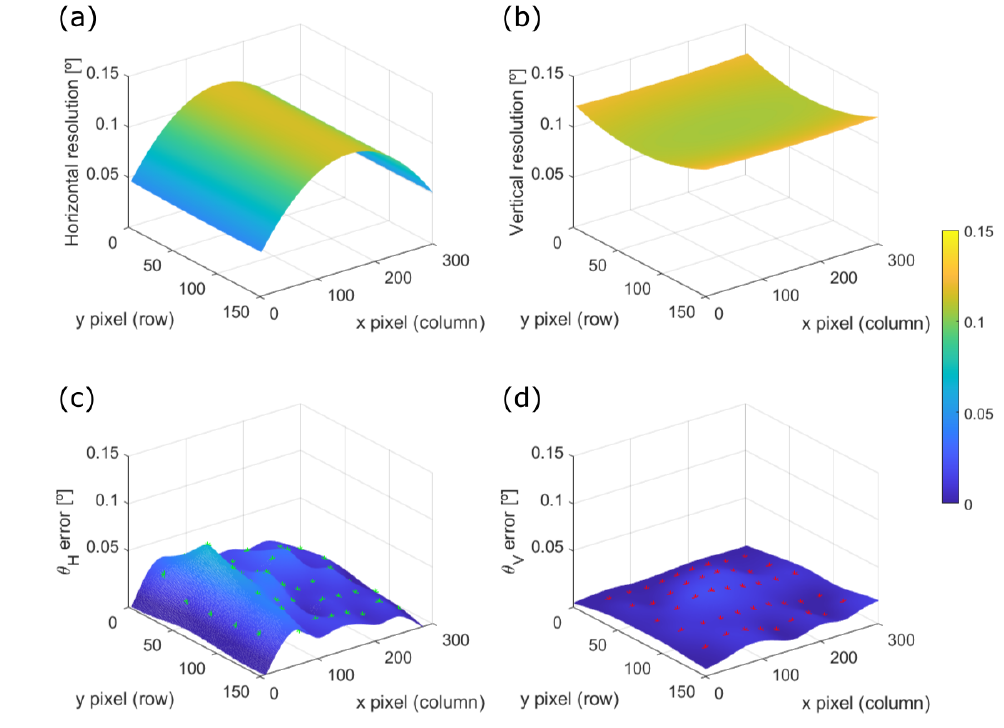
Figure 13. Results of the mapping function Map 3 for the 30 × 20 ◦ FOV prototype across its FOV. ( a ) Horizontal and ( b ) vertical angular resolution. ( c ) Horizontal and ( d ) vertical committed angular